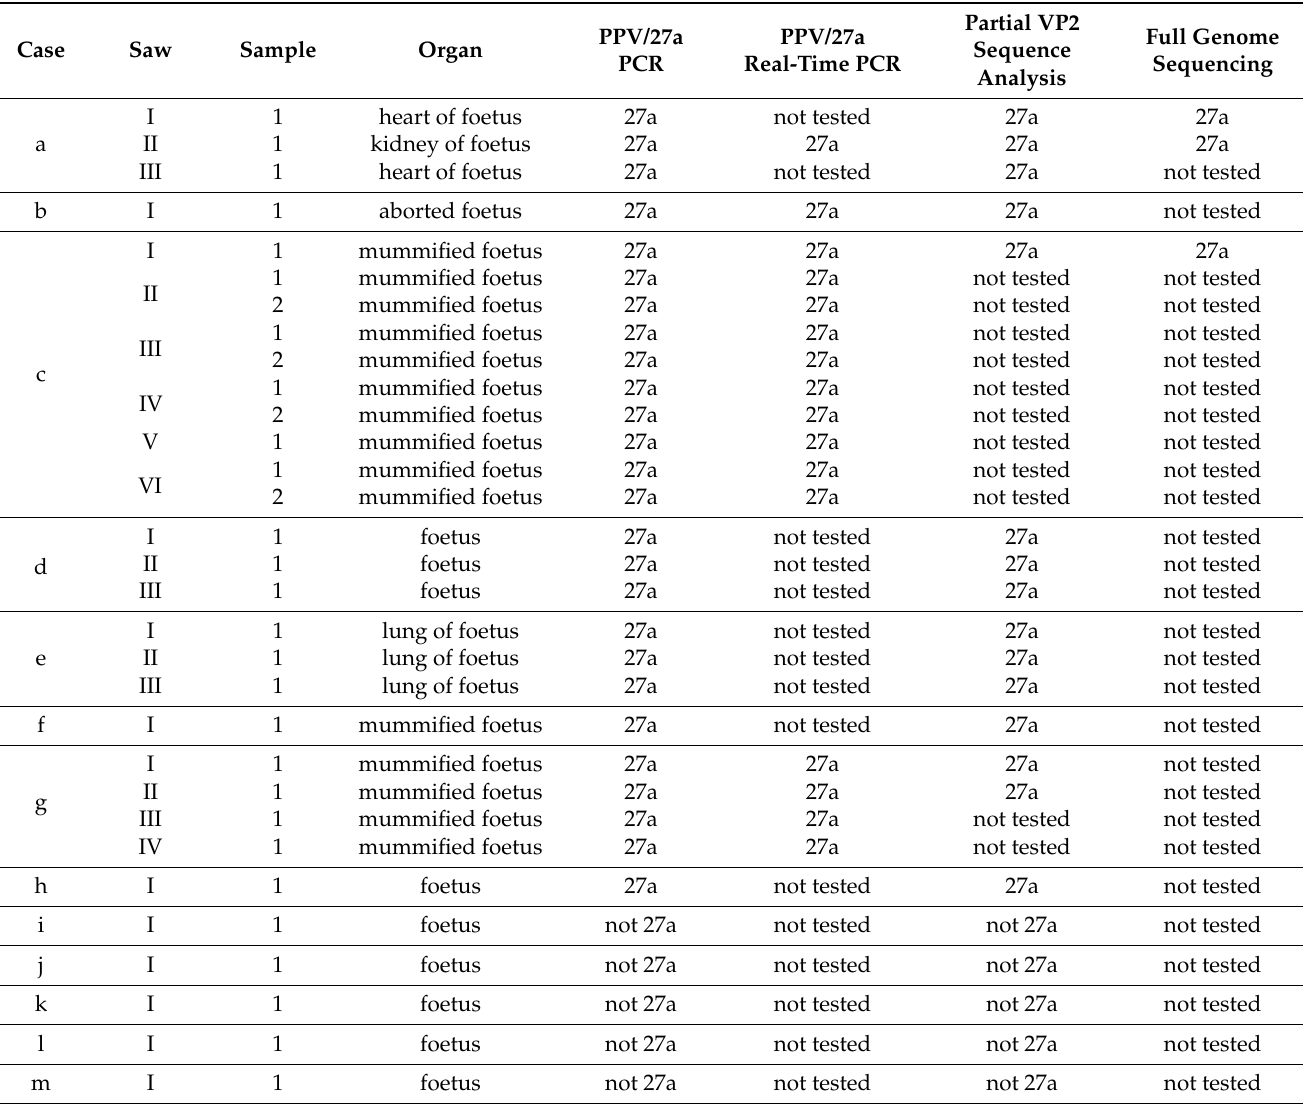
Table 3. Results of the different diagnostic methods on various samples collected from Western and Central